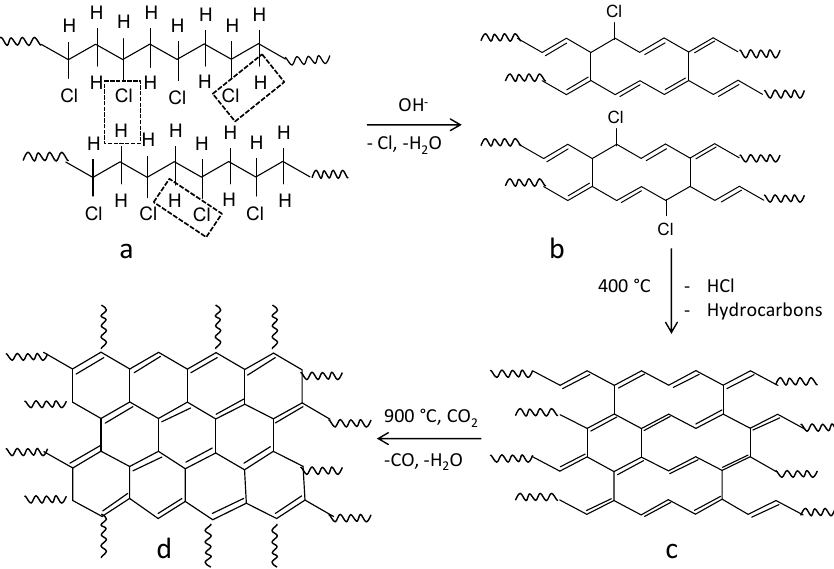
Figure 1. A scheme of CM synthesis via alkaline dehydrochlorination of PVC, low-temperature car- bonization and activation (cited from [58] and rearranged): ( a ) a fragment of the initial PVC mole- cule; ( b ) fragments of polyvinylene chains formed upon hydrodechlorination of PVC molecules; ( c ) a fragment of the condensation product of polyvinylene chains, ( d ) a carbon material formed by the high-temperature treatment in CO 2 medium.